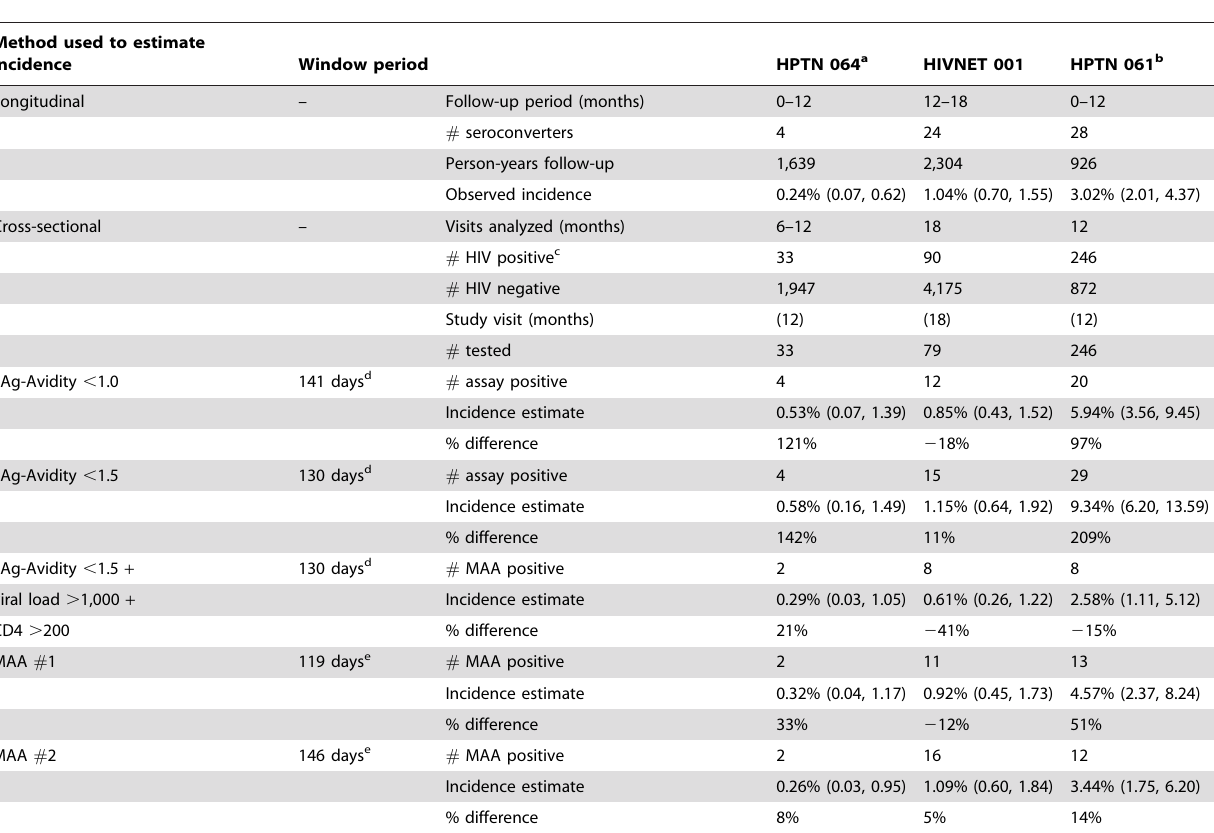
Table 4. HIV incidence estimates for three clinical cohorts in the United States.